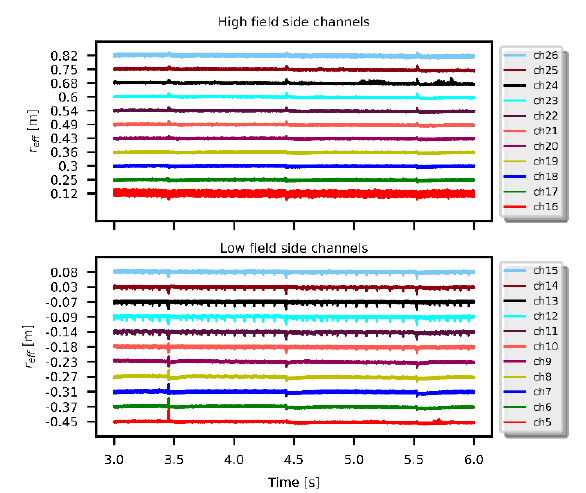
Figure 7 : discharge interval from 3s to 6s. ECE signals are normalised with respect to their average value. . Cold resonance position of channels is provided. . ECE cold resonance radii are represented on the y-axis.